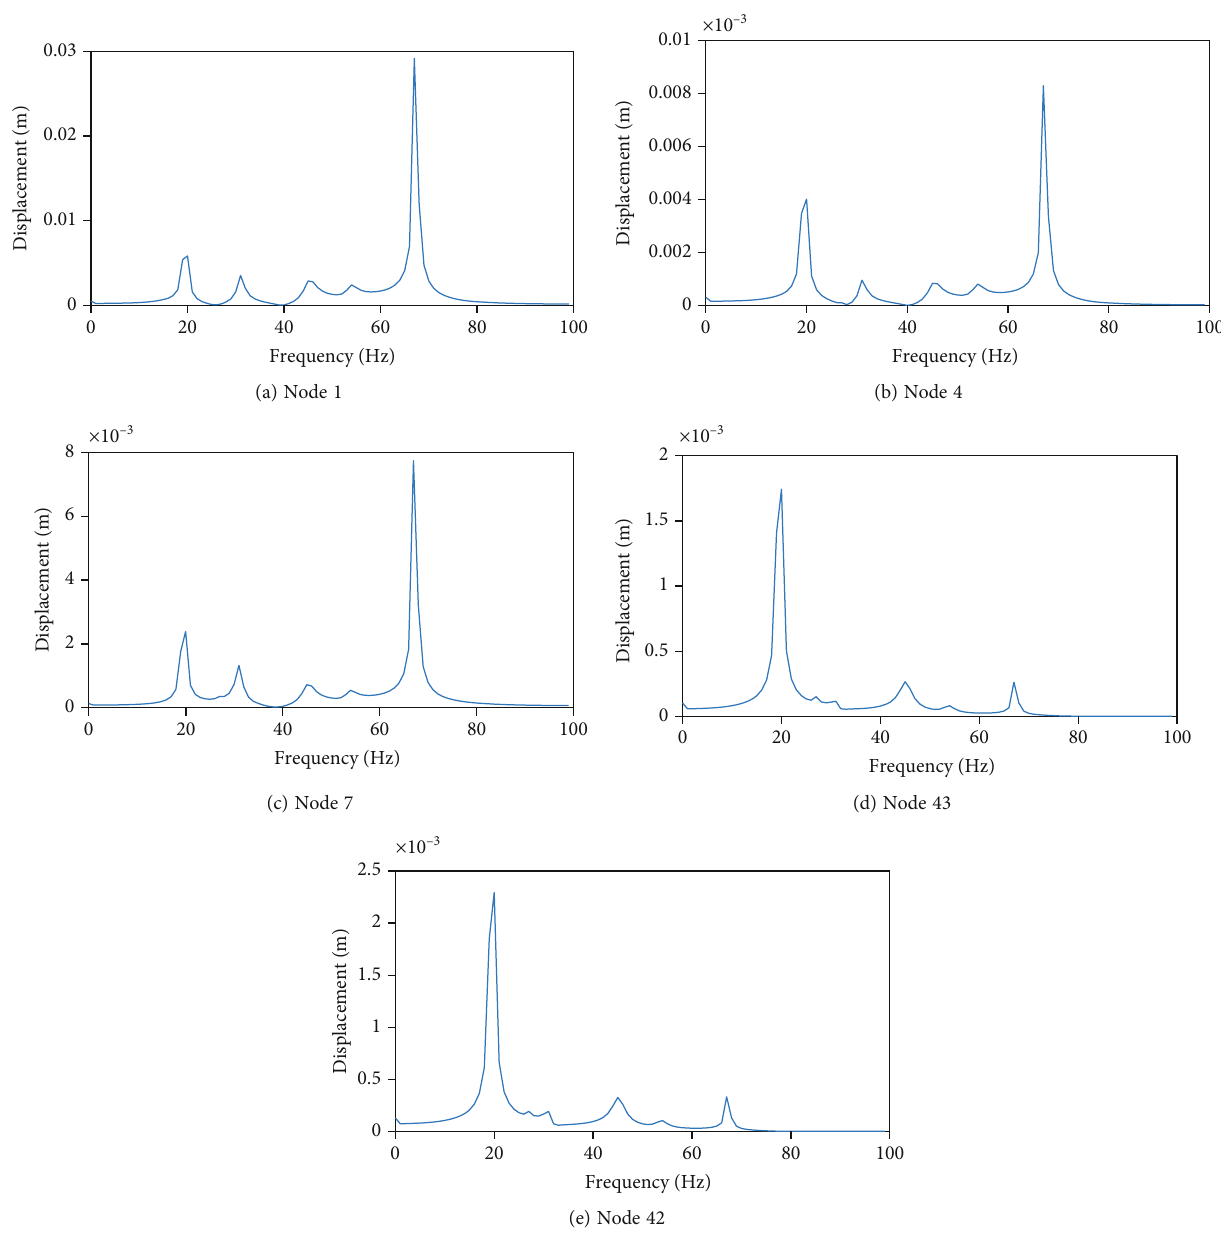
Figure 11: Response frequency analysis at key points in path